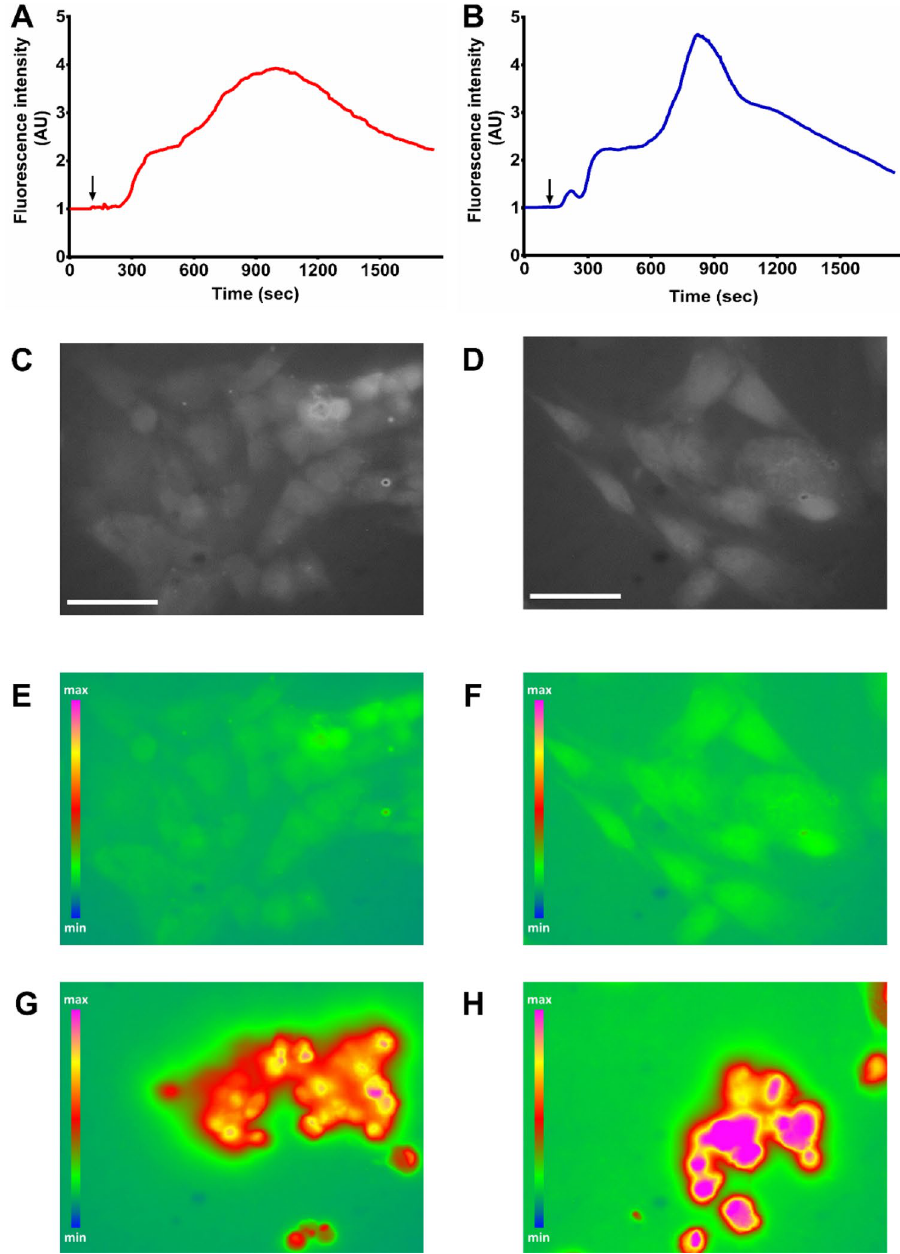
Figure 2. Live cell Ca 2+ imaging in hDPSCs. ( A , B ) show representative time courses of gross intracellular Ca 2+ dynamics for Biodentine ( A ) and ProRoot WMTA ( B ) induced by the two biomaterials (averaged signal over all cells in view). Arrows indicate exposure to the biomaterial lowered to contact the recording medium. ( C , E , G ) show representative Ca 2+ images for Biodentine, with ( C ) representing a B/W image of stem cells loaded with fluorescent Ca 2+ indicator to reveal the cells, ( E ) a pseudocolored Ca 2+ image taken before biomaterial exposure and ( G ) a Ca 2+ image at the peak of the global Ca 2+ change. ( D , F , H ) show corresponding images for exposure to ProRoot WMTA. Scale bar measures 50 µm; pseudocolor scale indicates fluorescent Ca 2+ indicator signal